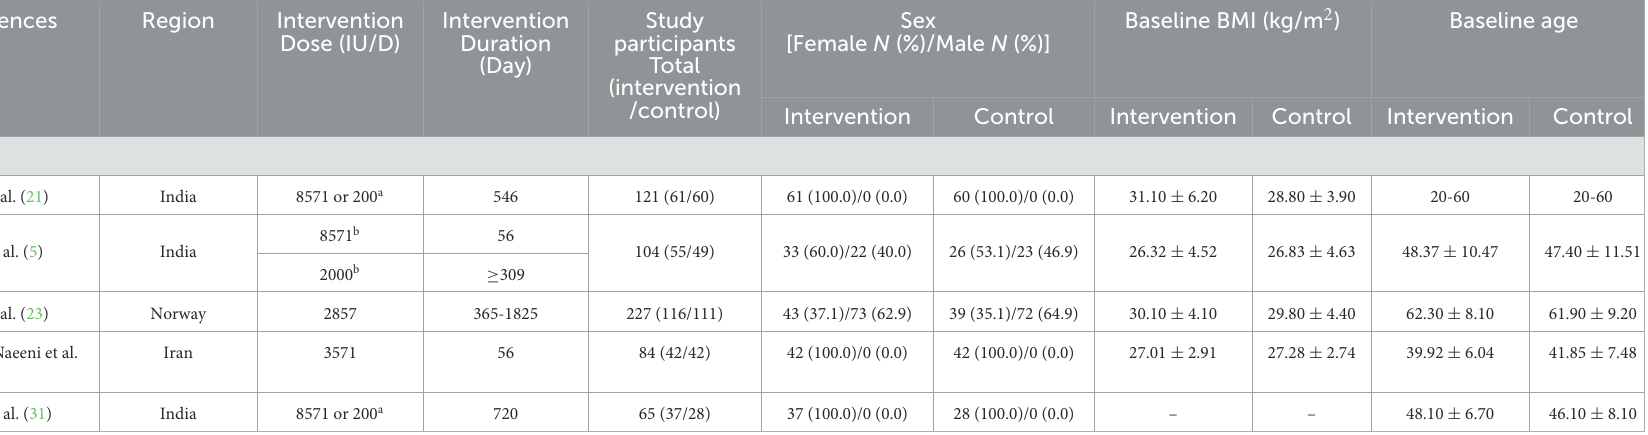
TABLE 1 Basic information of included